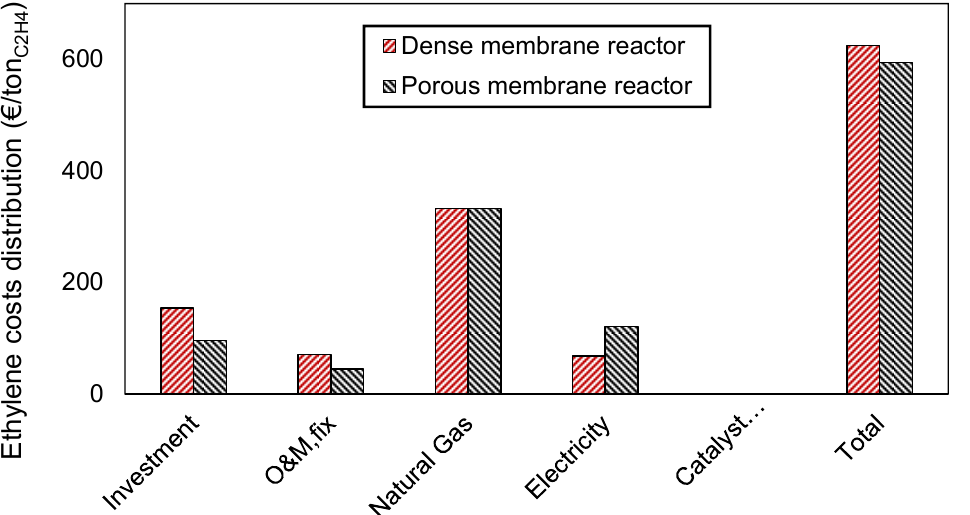
Figure 5. Disaggregated ethylene costs, including CAPEX and OPEX (Operational costs), for the OCM plant employing a dense membrane reactor (red) and a porous membrane reactor (black).